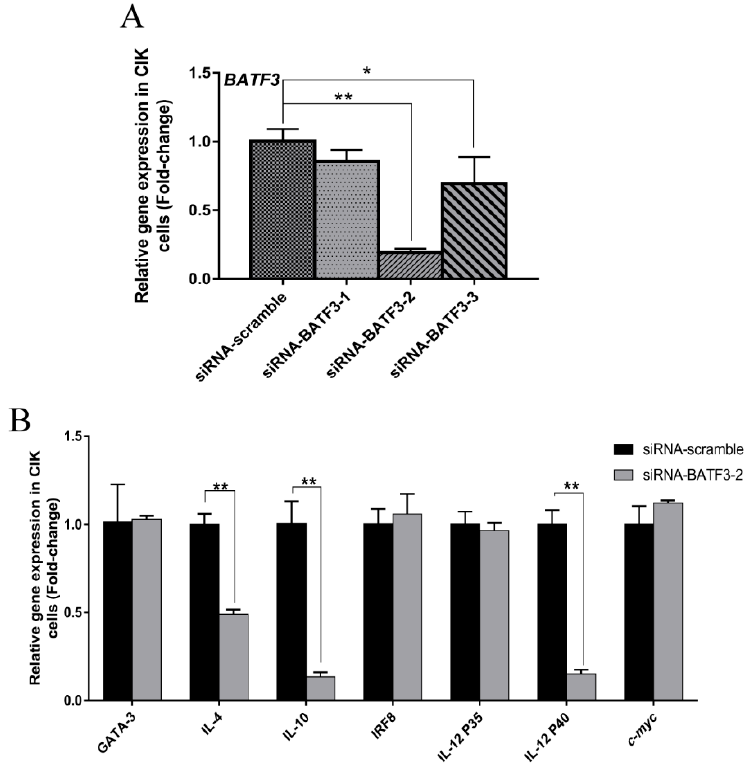
Figure 6. Gene expression profiles in CiBATF3 deficient CIK cells generated by siRNA. ( A ) Three siRNAs targeted to different sites of CiBATF3 were used to infected CIK cells, and siRNA-BATF3-2 has the highest efficiency in CiBATF3 gene silencing. ( B ) The expression of CiBATF3 , GATA3, IL-4, IL-10 IRF8, IL-12 p35, IL-12 p40 and c-myc at 24 h were assayed by RT-qPCR after infected with siRNA-BATF3-2. The expression level of the control group was set as the baseline (1.0) and the results are presented as the mean ± SD ( n = 3). siRNA-scramble: control siRNA infection; siRNA-BATF3: CiBATF3 siRNA infection. * = p ≤ 0.05, ** = p ≤ 0.01.